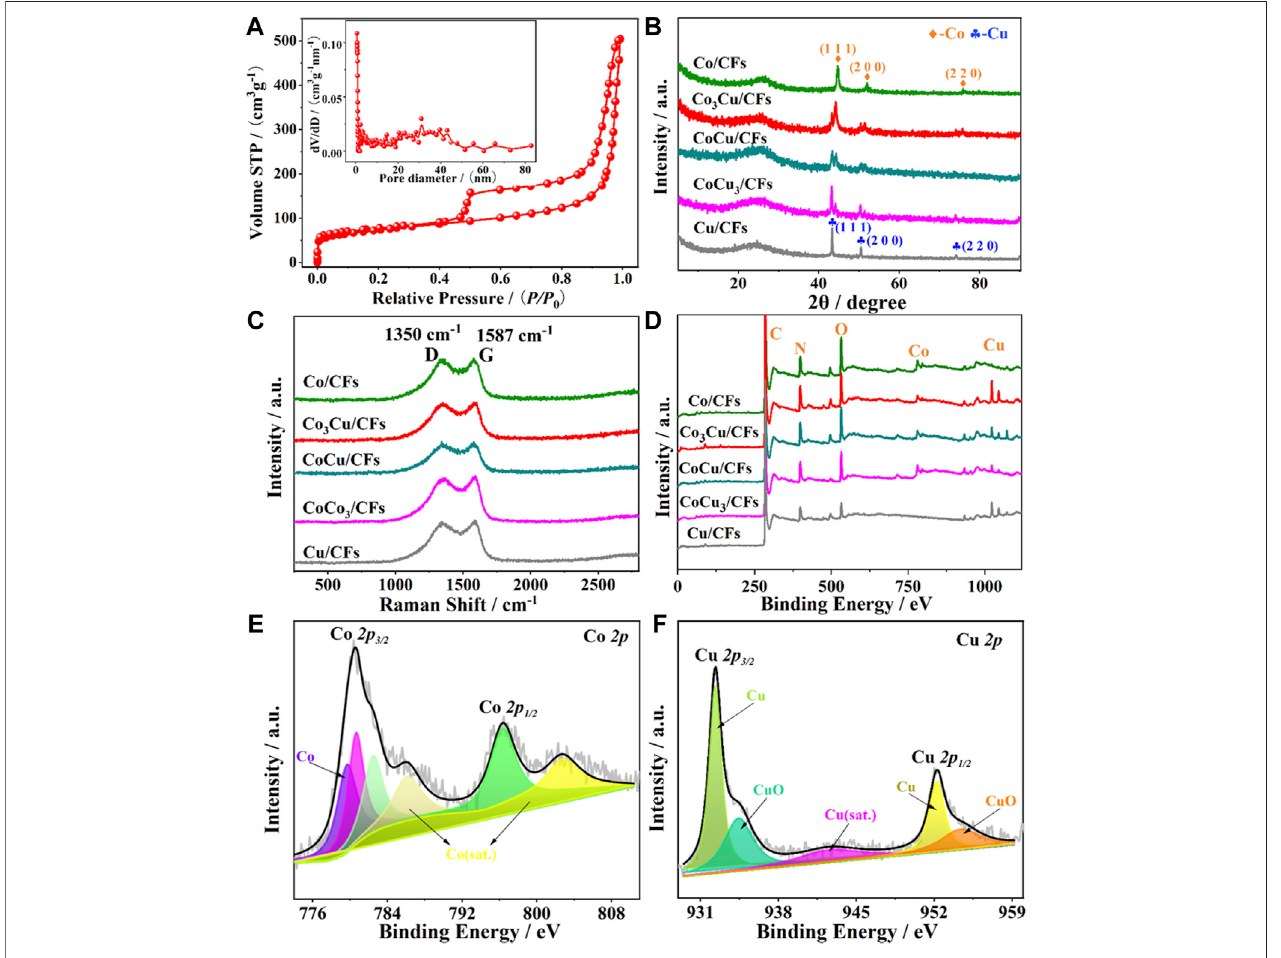
FIGURE3|(A) N 2 sorptionisothermsofCo 3 Cu/CFs:insetdisplaystheporesizedistribution; the fi ve catalysts; (E) Co 2p and (F) Cu 2p fi ne XPS spectra of Co 3